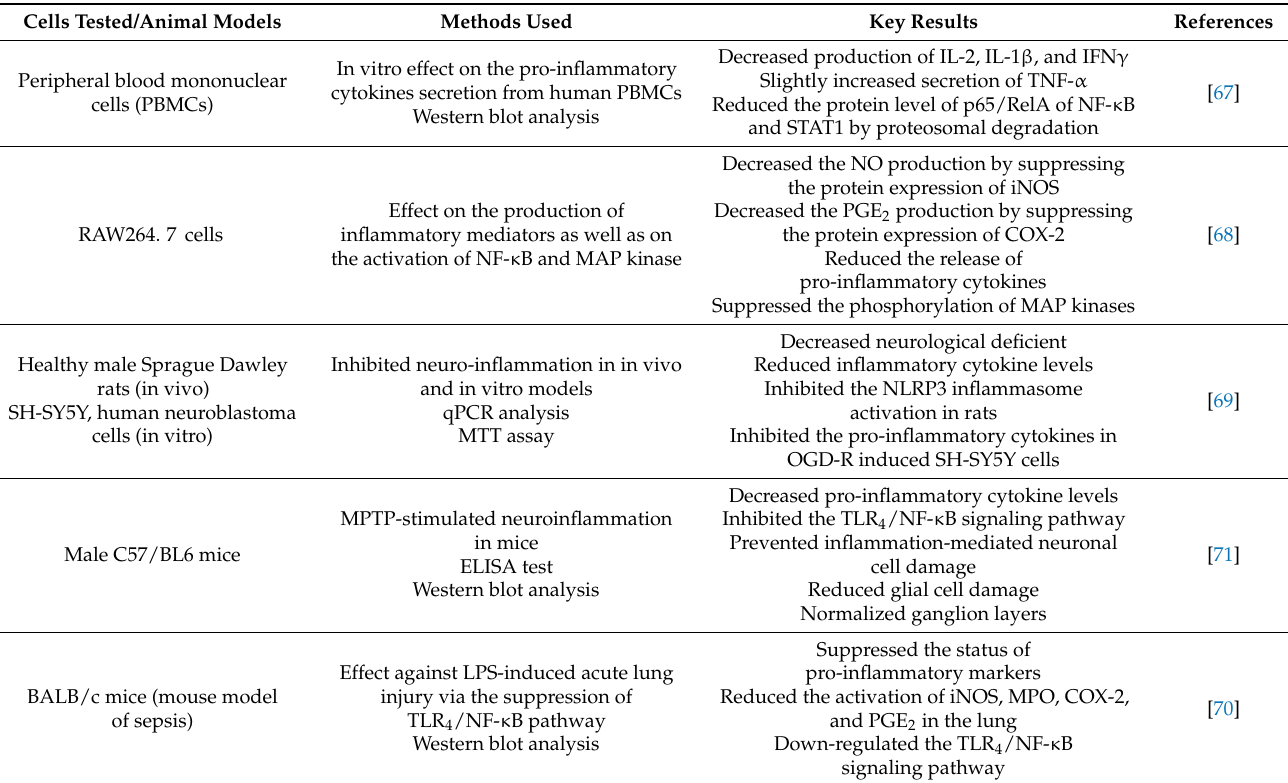
Table 3. Anti-inflammatory effect of